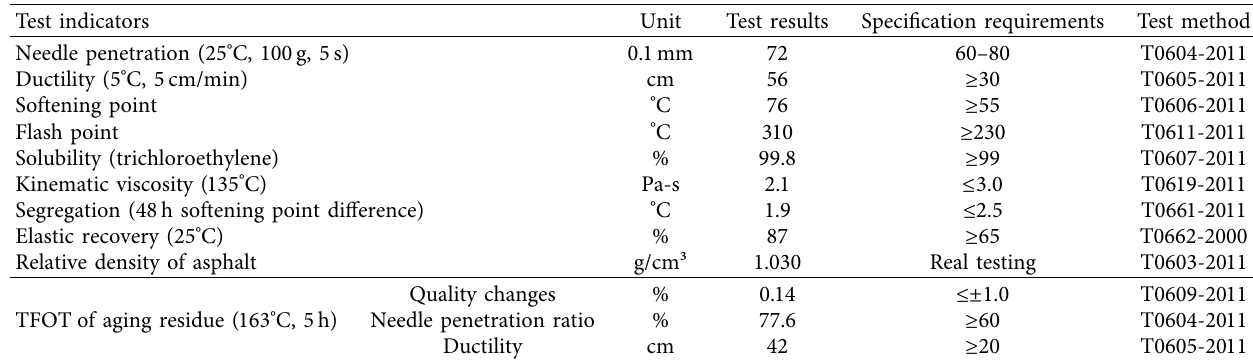
Table 10: Test results of SBS-modifed asphalt performance.